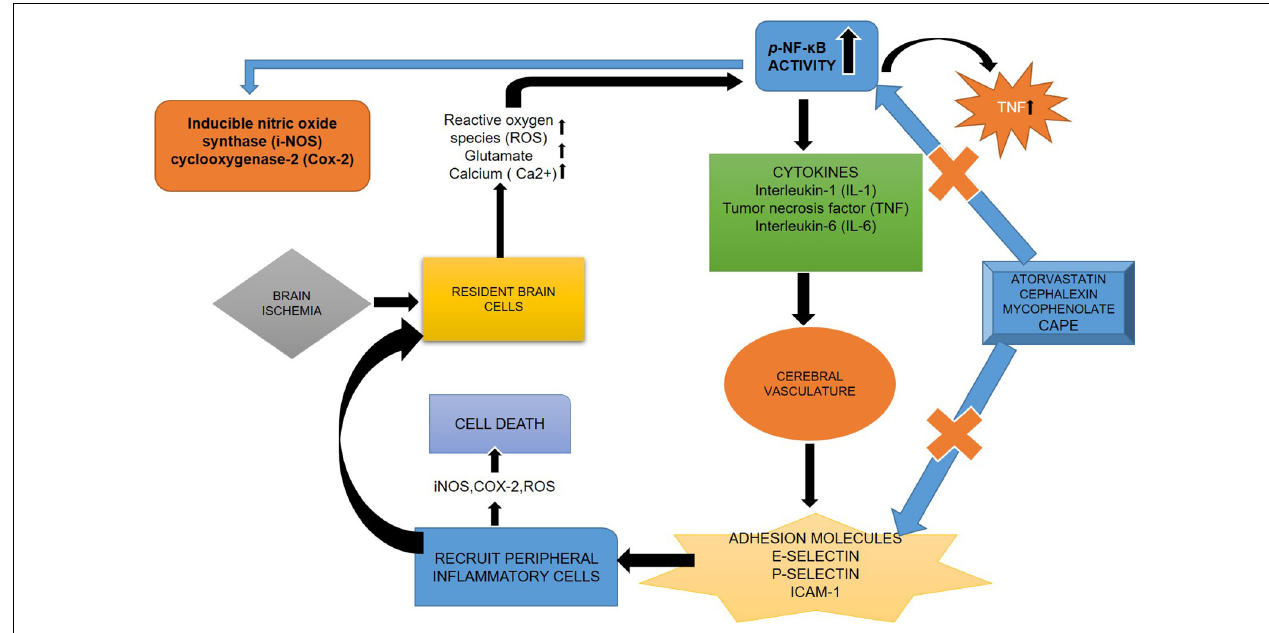
FIGURE 7 | Schematic diagram depicting pathological events following MCAO that mediate post-ischemic inflammation. NF- κ B activation regulates the inflammatory cytokines and adhesion molecules, and this leads to peripheral inflammatory cells migrating to the ischemic area and enhance ischemic brain injury.